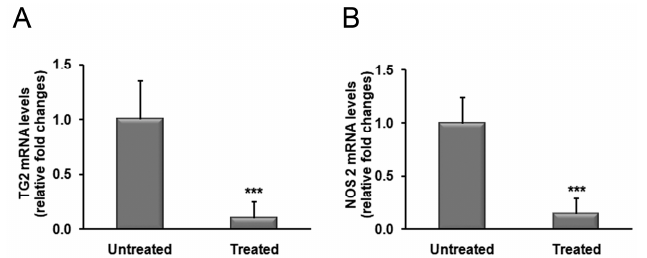
Figure 2. Transcript levels of TG2 ( A ) and NOS2 ( B ) in foreskin tissues from patients with BXO untreated or treated with OZOILE ® . Results from real-time PCR are expressed as relative fold change compared with foreskin from untreated patients. The data are the means ± standard error of the mean (SEM). *** p < 0.001 significant differences in comparison with untreated patients.